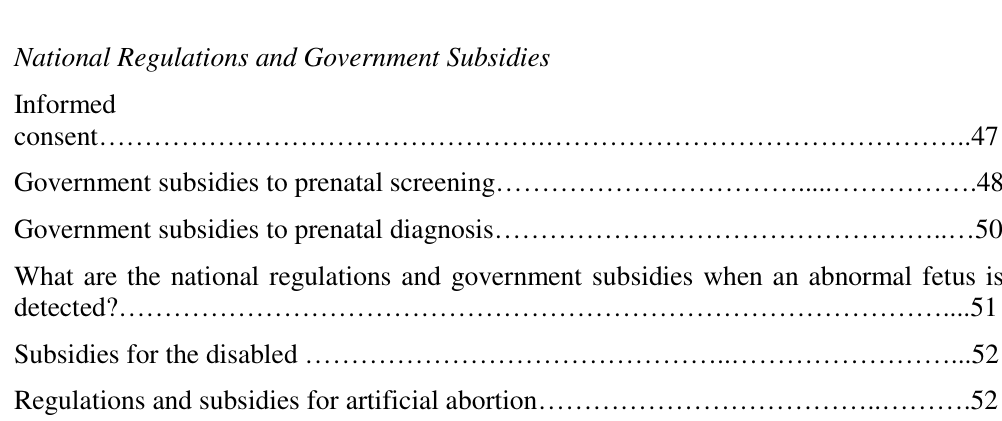
How to define the abnormal fetus……………….…………………..…..…………….…34 The more prenatal screening and prenatal diagnosis the better?……………….……..…35 Do people have the right to pursue healthy babies and even perfect babies?……………37 Should government secure unborn babies’ right to life?…………...………..…………..38 Do too many prenatal examinations create burdens for pregnant women?……...………42 Can prenatal examination enlarge the gap between the poor and the rich?……...………44 Will the pre-implantation genetic diagnosis objectify fetuses?…………..…………...…44